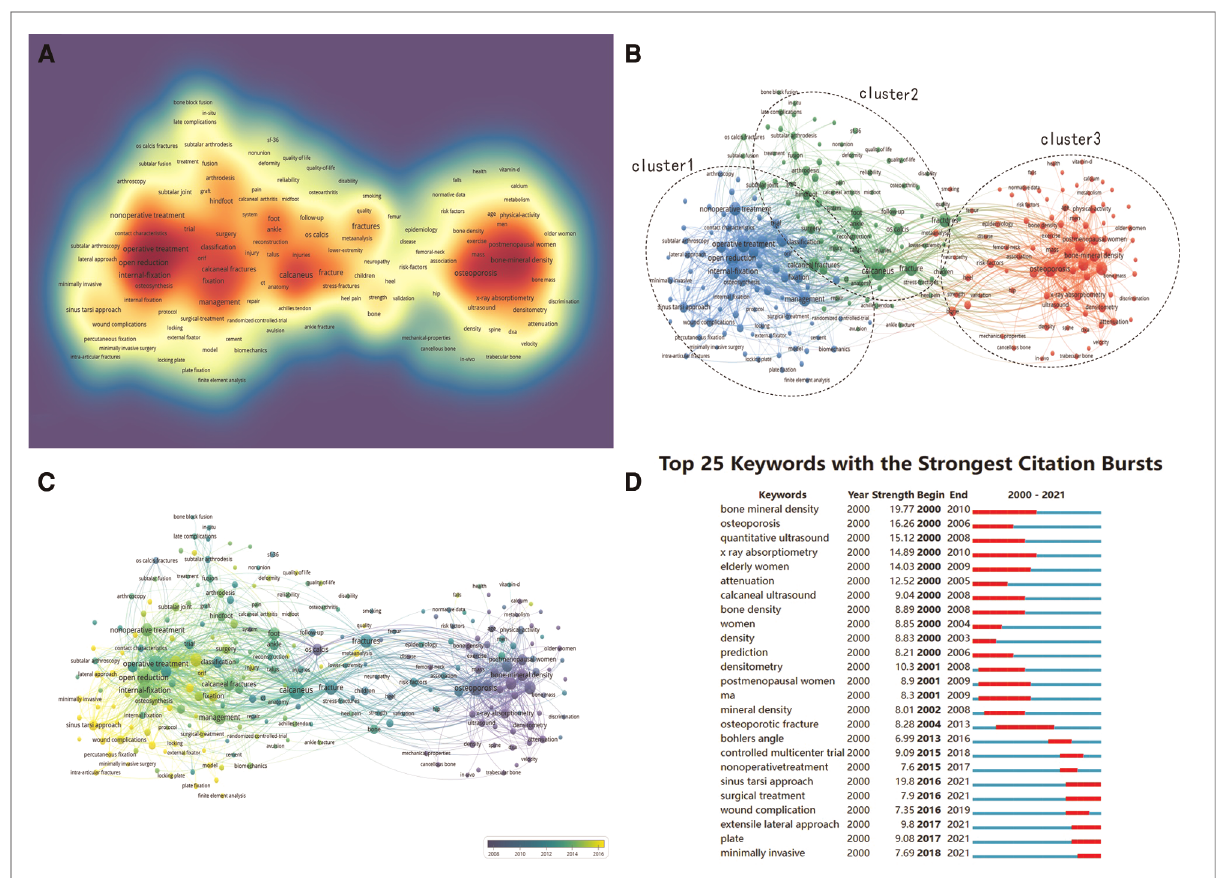
FIGURE 6 Co-occurrence analysis of global calcaneal fracture research. ( A ) Density map of the keyword co-occurrence analysis (generated by VOSviewer). The darker the color, the higher the keyword density. ( B ) Keyword analysis of research hotspots. Network visualization of the keyword co-occurrence analysis (generated by VOSviewer). ( C ) Overlay map of the keyword co-occurrence analysis using VOSviewer. ( D ) The 25 keywords with the strongest citation bursts between 2000 and 2021. The blue line indicates the time interval, and the red line represents the duration of the keyword ’ s strongest citation